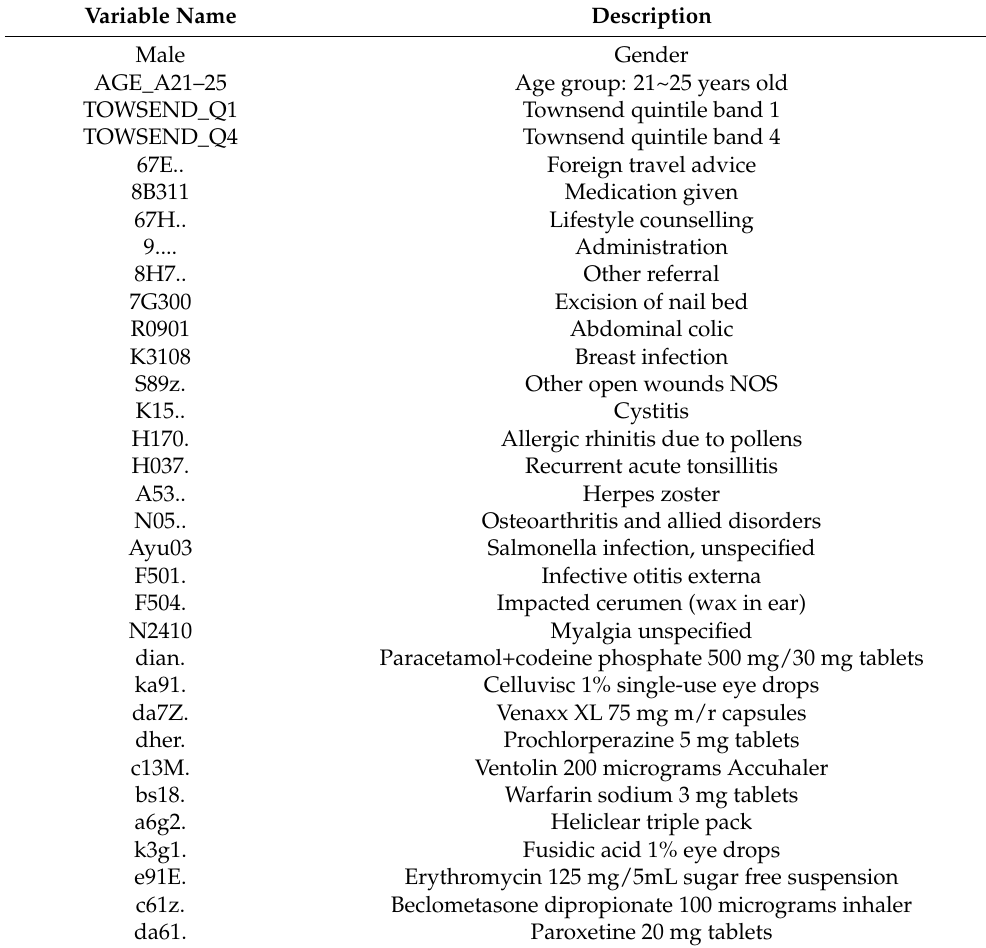
Table 2. The 33 key predictive variables